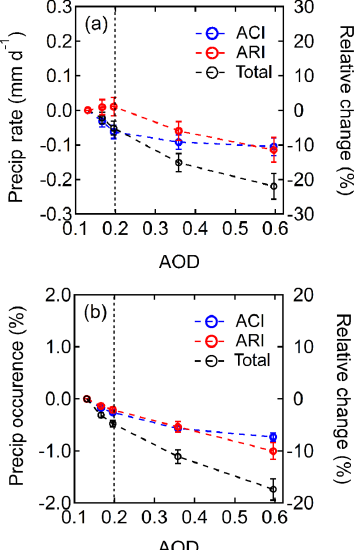
Figure 9. Changes in domain-averaged (a) precipitation rate and (b) precipitation occurrence with increasing BB emission intensity (indicated by domain-averaged AOD in each emission scenario). The vertical dotted line in each plot indicates the EMIS1 scenario. Error bars denote the standard